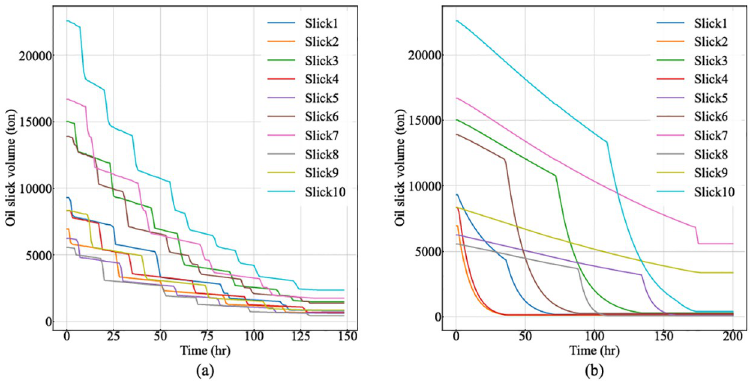
Fig 8. Variations of remaining oil volume for each slick in MAS-CoPSO and SDS. (a) The results of MAS-CoPSO. (b) The results of SDS.